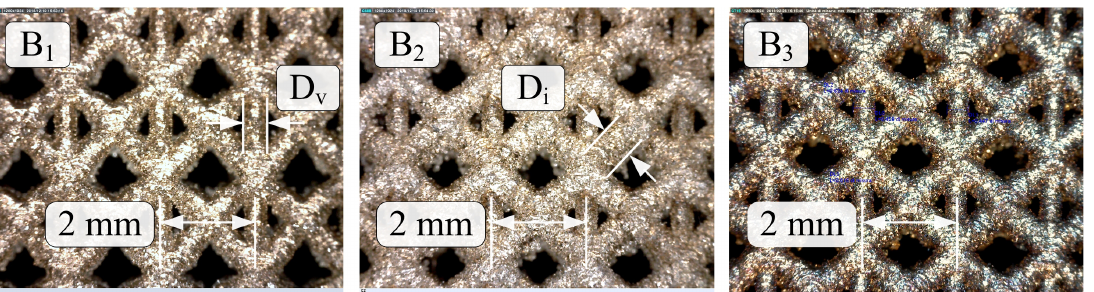
Figure 3. Images of the three replicates of lattice structure type B acquired by a digital microscope, for quality and dimensional